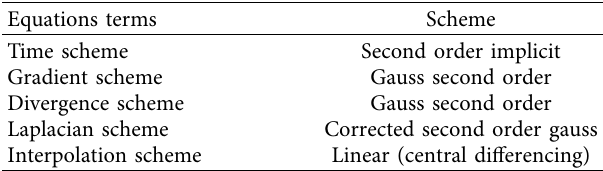
Table 4: Numerical schemes used the CFD simulations S5 and S6.